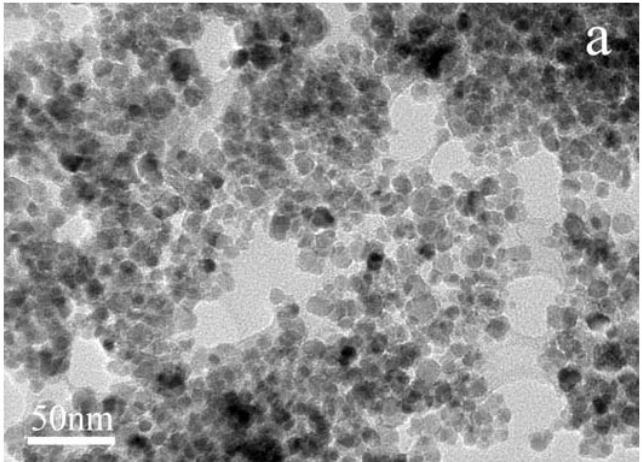
O nanoparticles (a) and magnetic microspheres 3 4